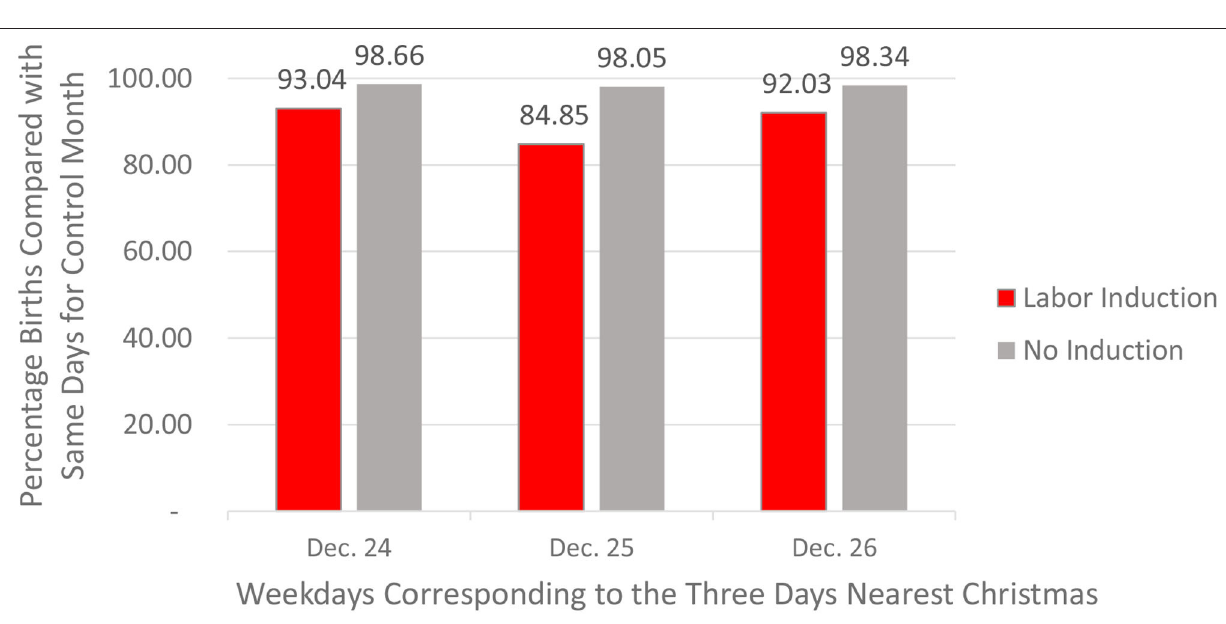
at rates lower than those expected based on the matched